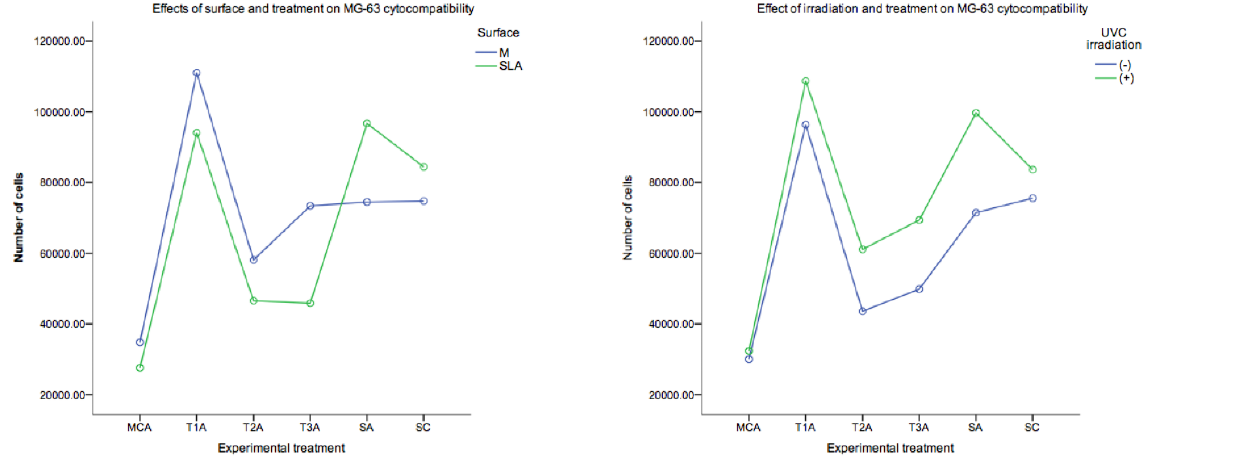
Figure 6. Evaluation of human osteoblast-like osteosarcoma cell line (MG-63) ( a ) proliferation across experimental treatments on Machined and SLA substrata ( n = 3). The UVC-irradiated substrate ( b ) (in T1+, T2+, T3+, SA+, SC+) was shown to have a greater cell proliferation (n= 3) (p= 0.0001).